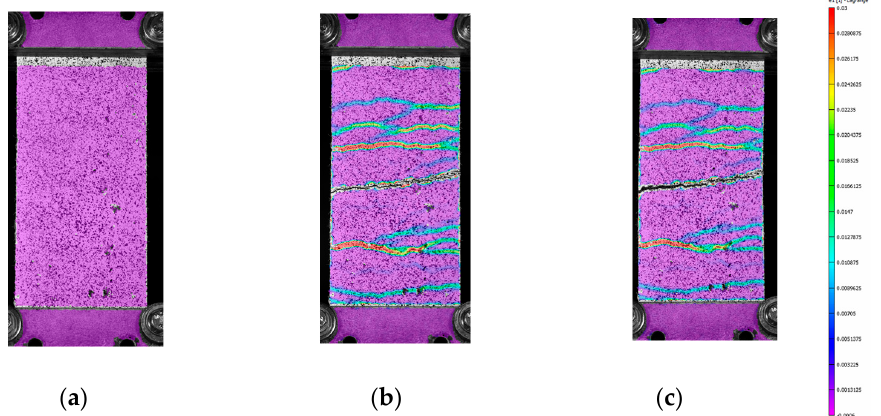
Figure 9. Crack pattern evolution of specimen BPf-3-A ( a – c ) during the tests. Pictures are taken at the beginning of the test ( a ), the end of the plateau ( b ) and immediately after the final drop in load ( c ). The scale of color represents the grade of the major principal strains, from 0.03 units in red to − 0.0007 units in purple.